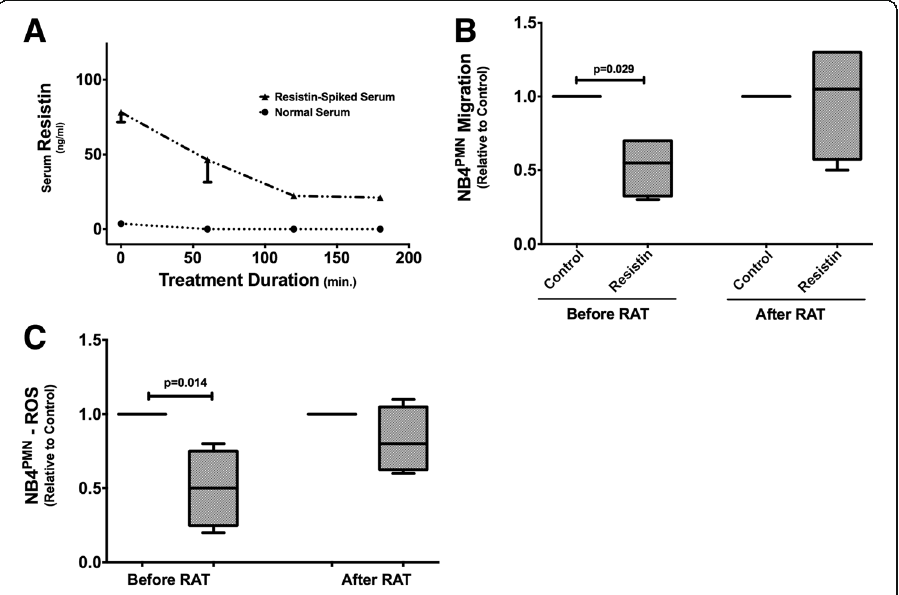
Fig. 4 Hemoadsorption therapy using Amberchrome CG161M ™ columns reduces serum concentrations of resistin ( a ). Amberchrome CG161M ™ treatment als restores impaired NB4 PMN cell transwell migration ( b ) and ROS production back to normal levels ( c ). N = 4 for all experiments